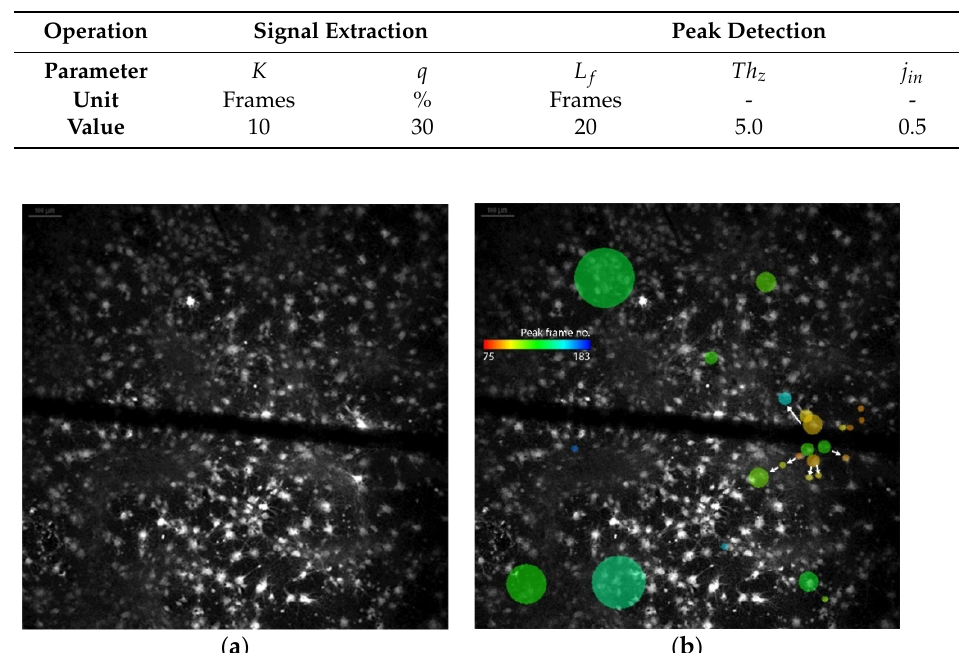
Figure 4. Stimulus-induced activity in primary cortical rat cells. ( a ) Wistar rat cortical cells loaded with green-fluorescent Fluo-4 AM. ( b ). Spatio-temporal map of the activity in the culture with the color of a dot representing the mean of the Figure 1. The arrows indicate the apparent directions in which the activity travels. Note that the green ROIs where the cascade starts are reactivated, and thus, show some activity later in the experiment as well as early.